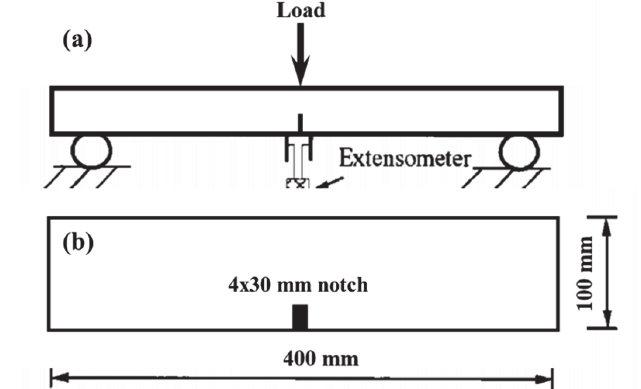
Figure 1: Schematic diagram of (a) Test setup; (b) Specimen geometry.